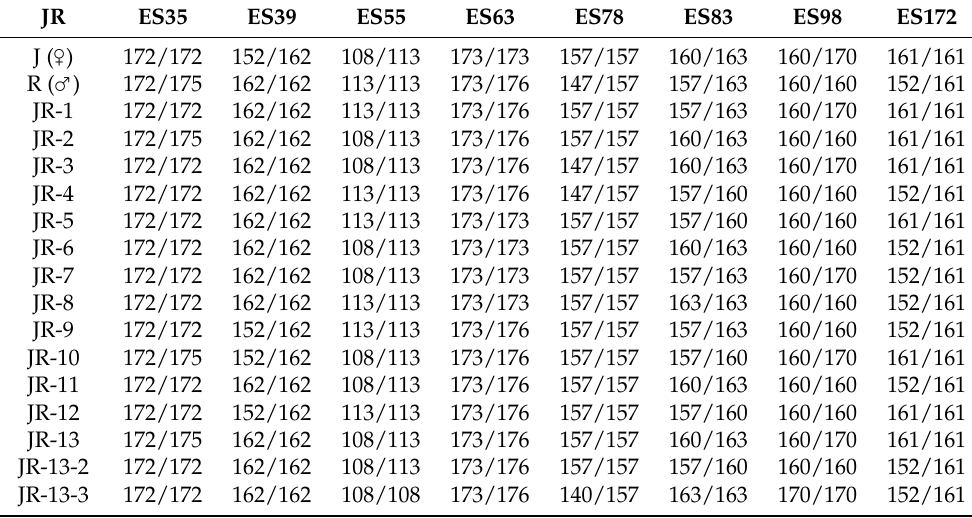
Table 2. PCR product size (bp) for eight SSR primers obtained from gene scan analysis for